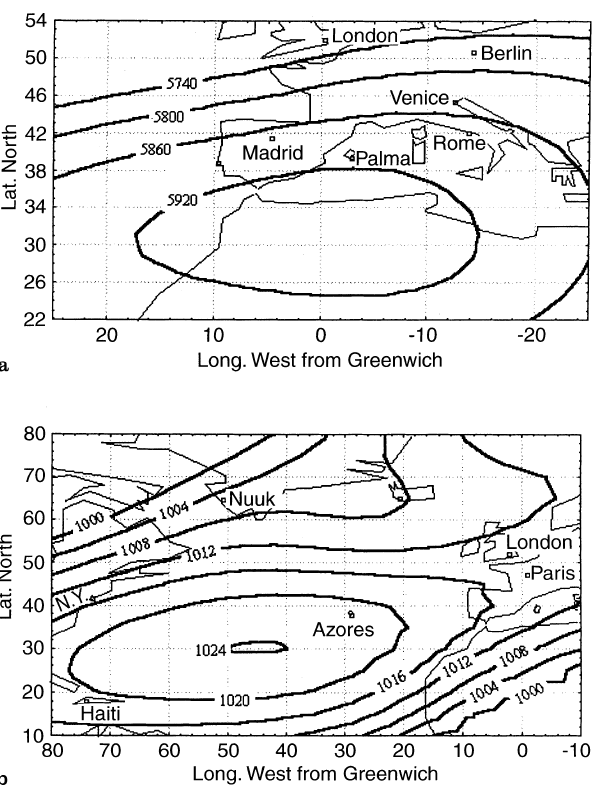
Fig. 2. a Upper: geopotential pattern over the western Mediterranean in July 1950. b Lower: sea-level pressure pattern over the North Atlantic area in July 1950